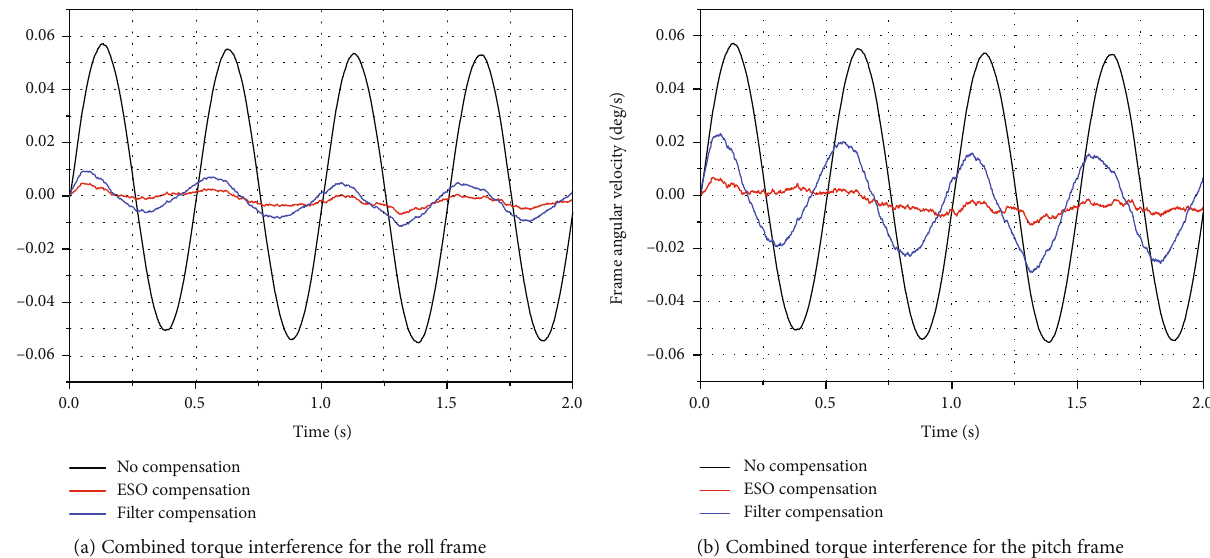
Figure 11: Angular velocity under combined torque interference after ESO compensation with k